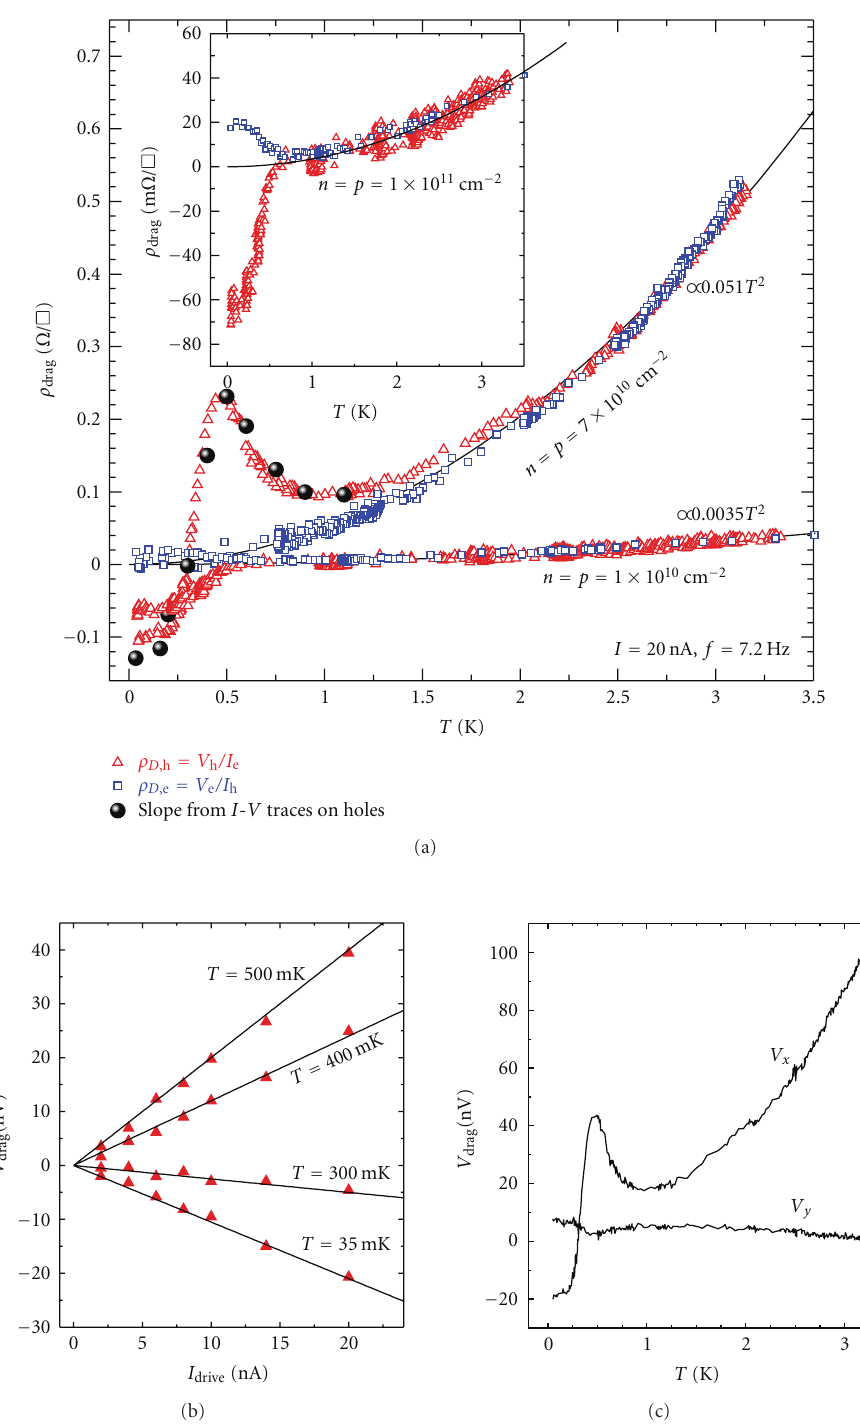
Figure 12: (a) Electron and hole drag resistivity versus temperature for n = p = 7 and 11 × 10 10 cm − 2 versus temperature, down to 50mK. T 2 coe ffi cients are 0.0035 and 0 . 051 Ω / (cid:2) K − 2 , respectively. (b) I - V (a.c. f = 7 . 2Hz) trace for drag on hole layer for n = p = 9 × 10 10 cm − 2 at temperatures indicated. The resistances found from these slopes are displayed on (a). (c) In- and out-of-phase components of the drag voltage ( V drag ) for the n = p = 7 × 10 10 cm − 2 trace. Electron and hole layer mobilities for n = p = 7 × 10 10 cm − 2 at T = 1 . 5K; μ e = 6 . 8 × 10 5 cm 2 V − 1 s − 1 and μ h = 3 . 3 × 10 5 cm 2 V − 1 s − 1 . (Device: B135/C3-4-25nm